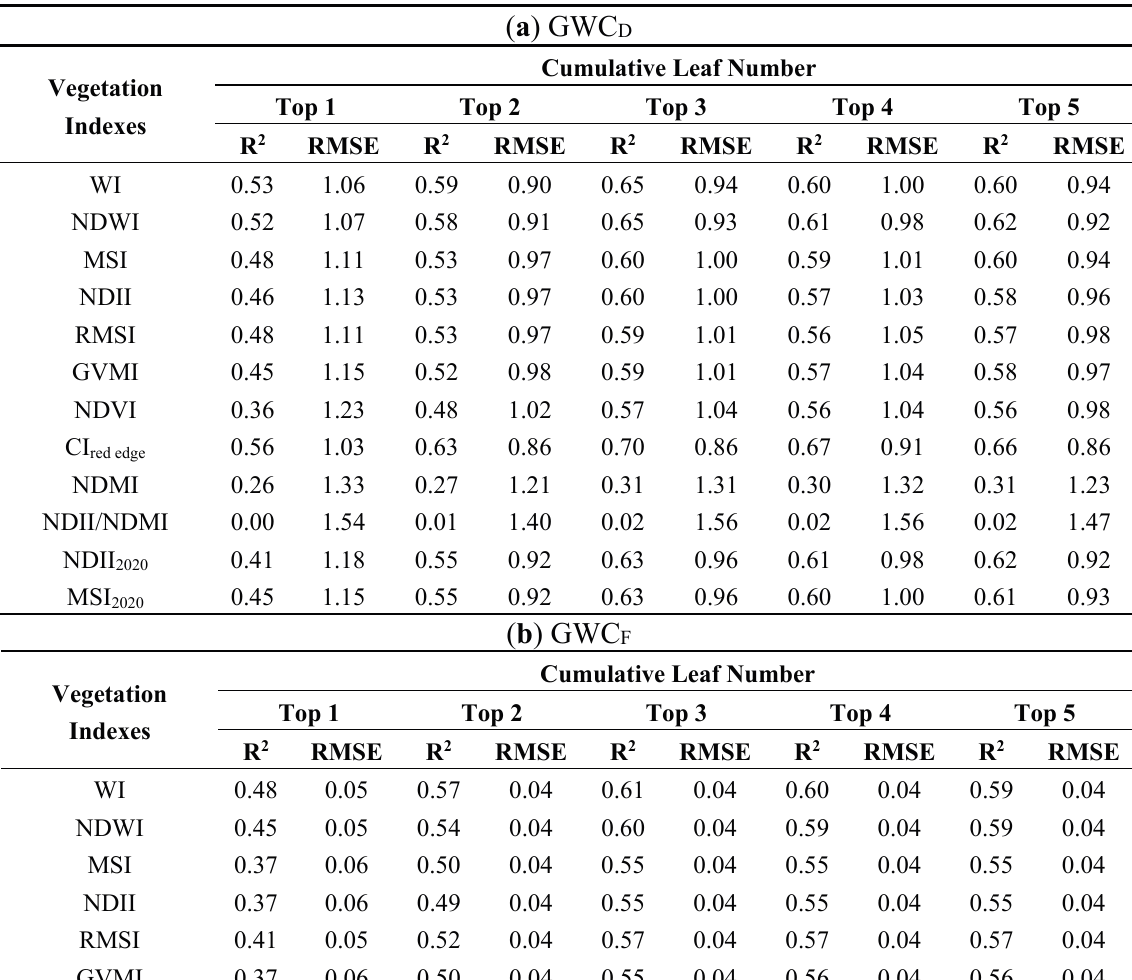
Table 7. Statistics of relationships between VIs based on canopy reflectance and GWC D ( a ), GWC F ( b ), RWC ( c ), and EWT ( d ) for the cumulative leaf number within the winter wheat canopy. The significant relationships ( p < 0.001) were indicated by R 2 values greater than 0.29 (33